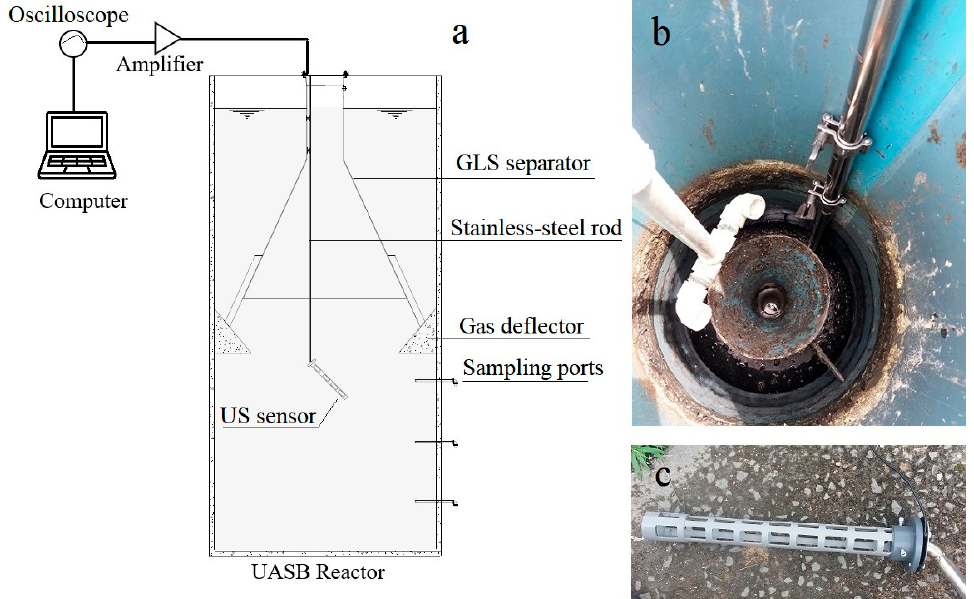
Figure 2. Setup used for the demo-scale experiments. ( a ) Cross-section of the UASB reactor showing the position where the sensor was installed. ( b ) Top view picture of the UASB reactor, which shows the stainless still support used to fixate the sensor. ( c ) Photo of the sensor housing before it was inserted in the reactor.